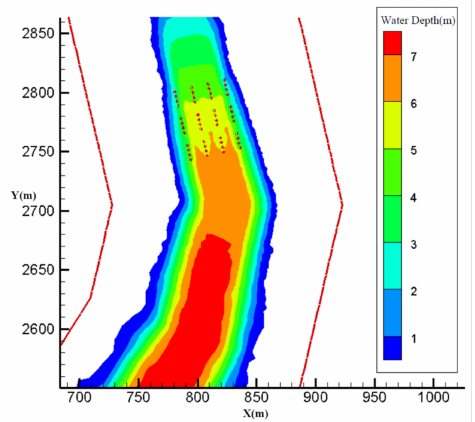
Figure 17. Water level at B1 bridge at time 660 s.